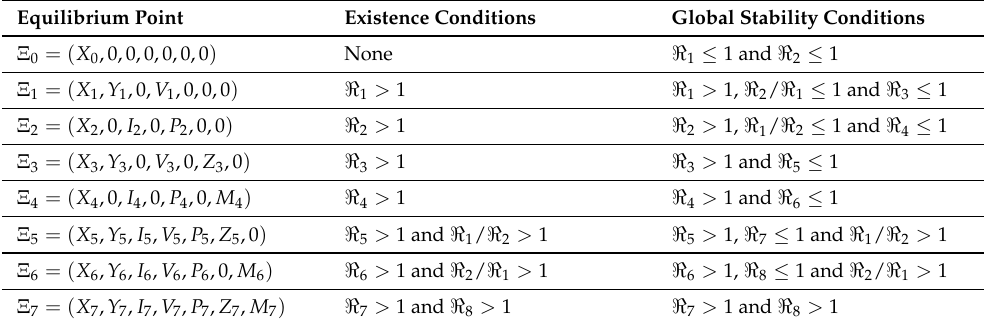
Table 1. Conditions of existence and global stability of the system’s equilibria.